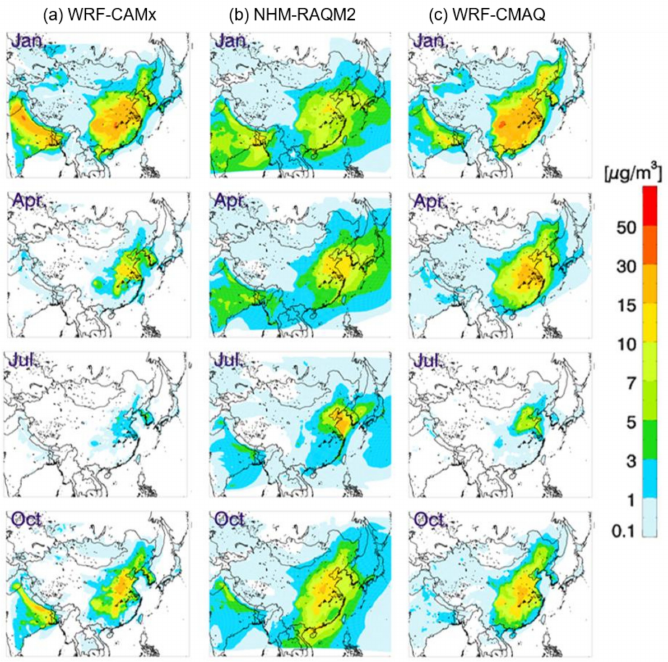
Figure 4. As in Figure 2, but for NO 3 − concentrations ( µ g/m 3